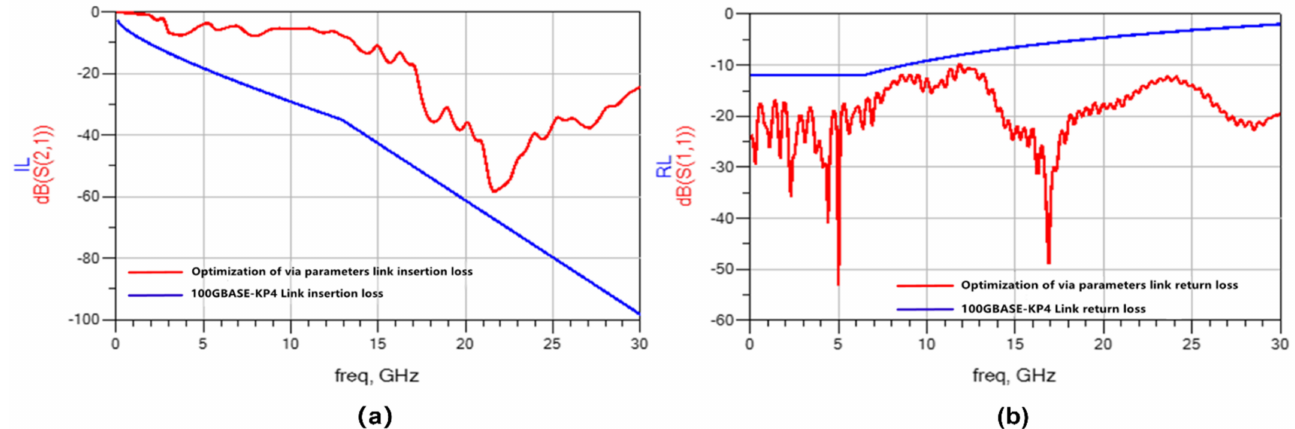
Figure 14. ( a ) Insertion loss of backplane link after optimizing via parameters; ( b ) return loss diagram of backplane link after optimizing via